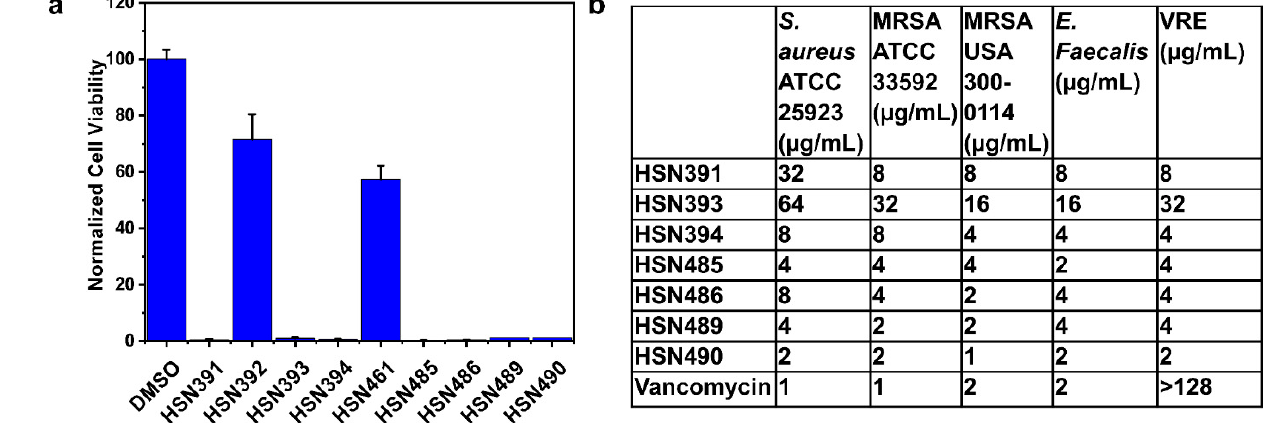
Figure 3. Alkynyl isoquinoline inhibition of bacteria growth. ( a ) S. aureus cell viability after treatment with 16 µ g/mL alkynyl isoquinolines. ( b ) Minimal inhibitory concentrations for alkynyl isoquinolines compounds against methicillin-sensitive S. aureus , methicillin-resistant S. aureus (MRSA) , vancomycin- sensitive E. faecalis and vancomycin-resistant E. faecalis